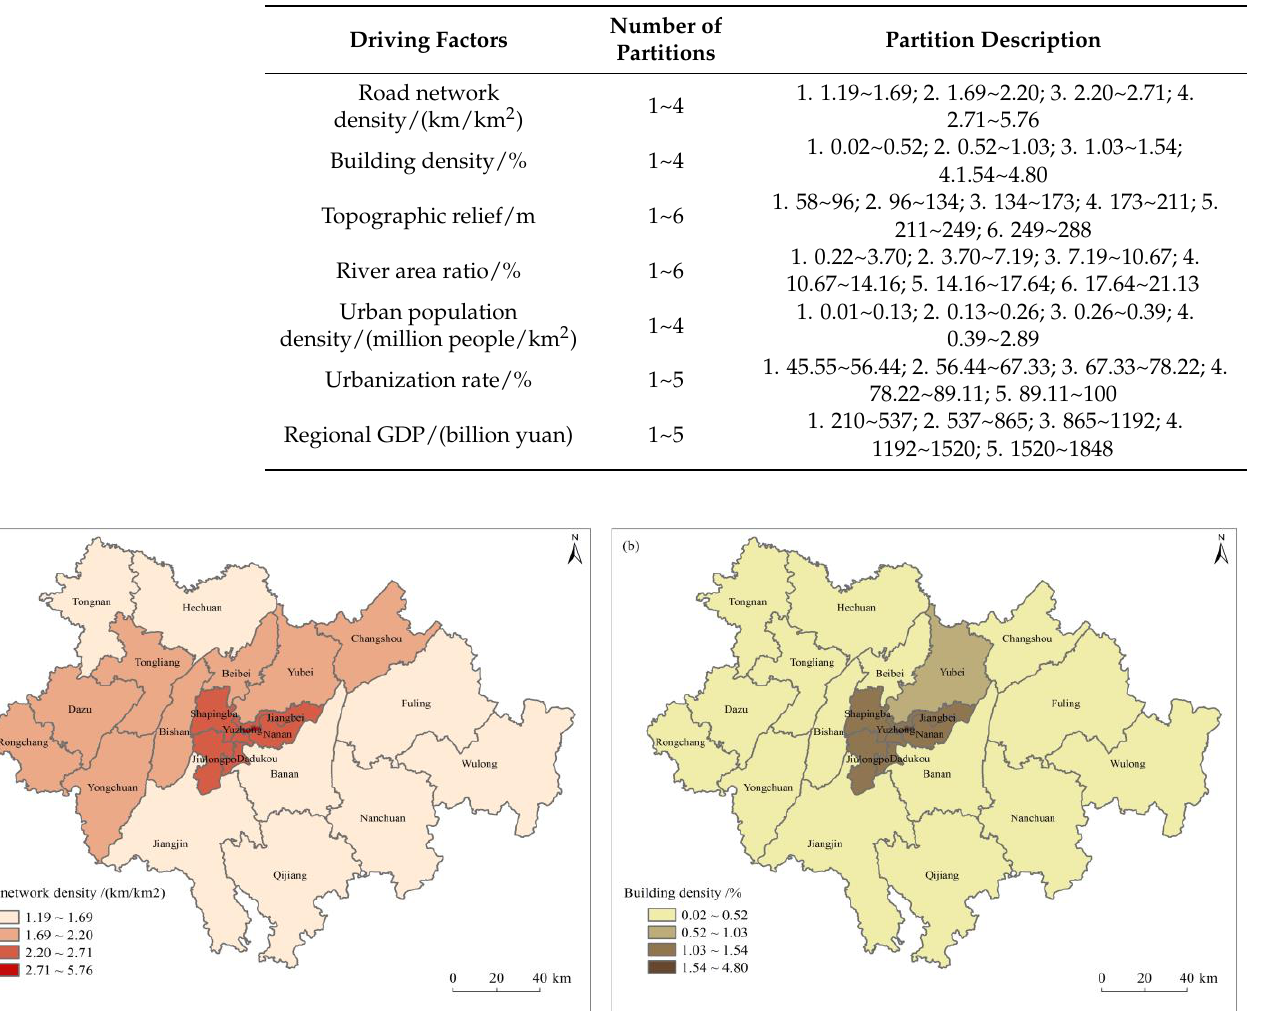
Table 2 . Driving factor partition description in geographic detector. Table 2. Driving factor partition description in geographic detector.